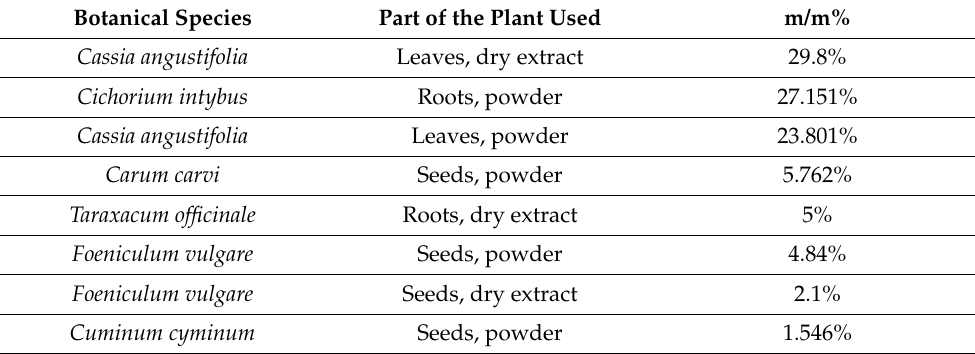
Table 1. Botanical composition of SMD tablets expressed as m/m% (i.e., (mass of a single compo- nent/total mass) × 100).